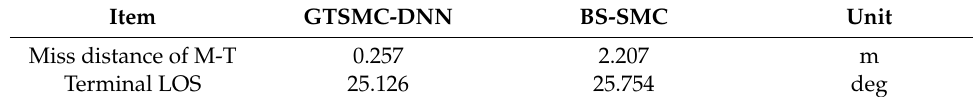
Table 3. The miss distance and terminal LOS angle.